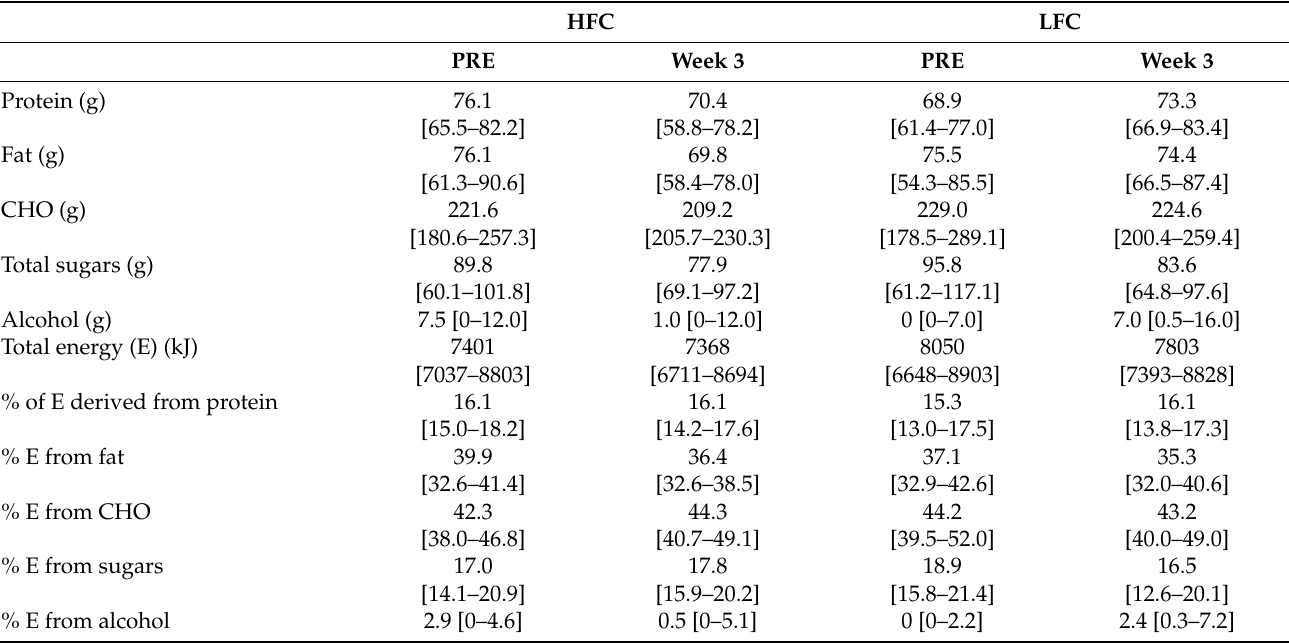
Table 3. Macronutrient dietary intake pre- and in week 3 of the supplementation period.